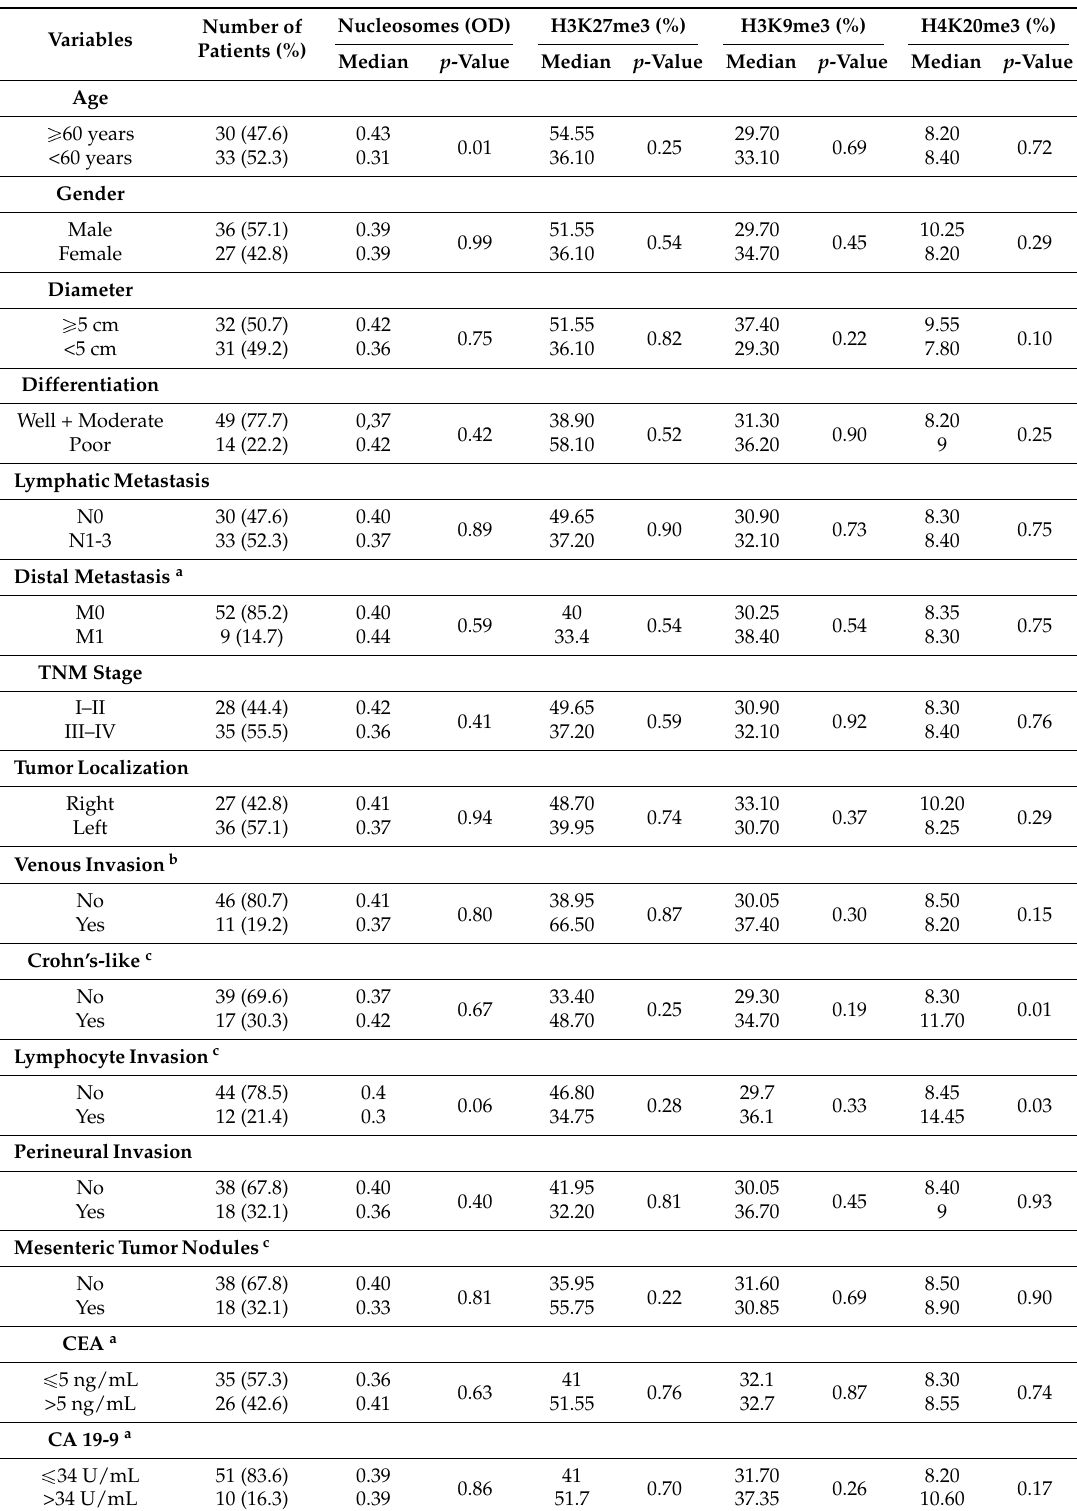
Table 1. Association of nucleosomes, H3K27me3, H3K9me3, and H4K20me3 with clinical